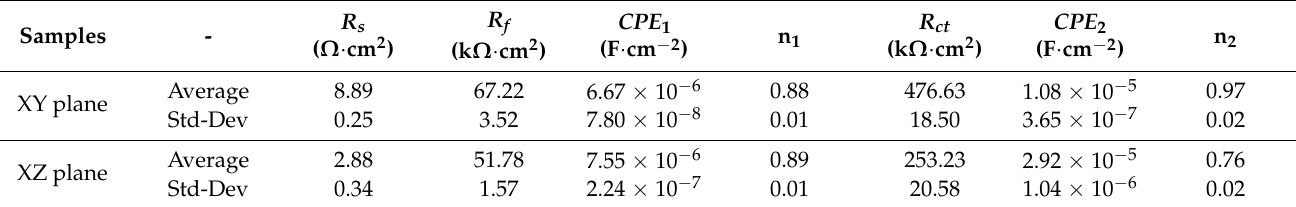
Figure 12. EIS results of samples for different planes in 3.5 wt.% NaCl solution (25 °C): ( a ) Nyquist plots; ( b ) equivalent electrical circuit for the EIS test; ( c , d ) bode plots. Table 2. Fitting results of EIS measurements for as-built samples on different planes.